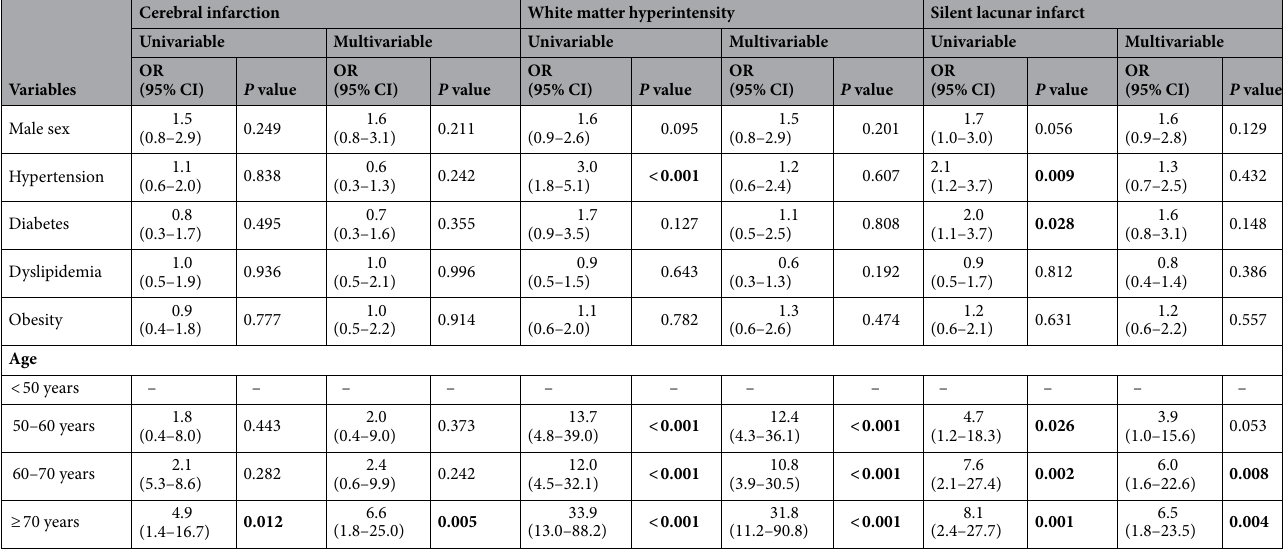
Table 4. Uni- and multi-variable analysis for cerebral infarction, white matter hyperintensity, and silent lacunar infarct based on findings on Cerebral magnetic resonance imaging. P < 0.05 was deemed to indicate clinical significance, values in boldface are statistically significant. OR = odds ratio, CI = confidence